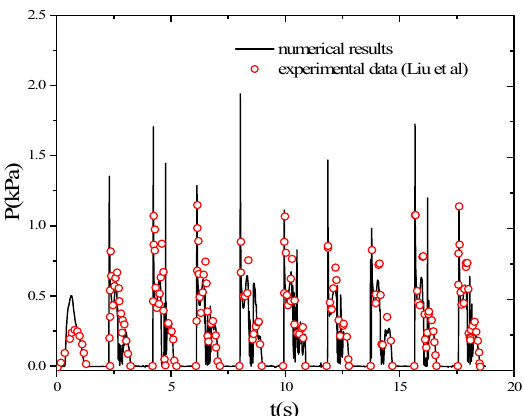
Figure 10. The validation of the pressure history curve, experimental data (et al.) from [27].